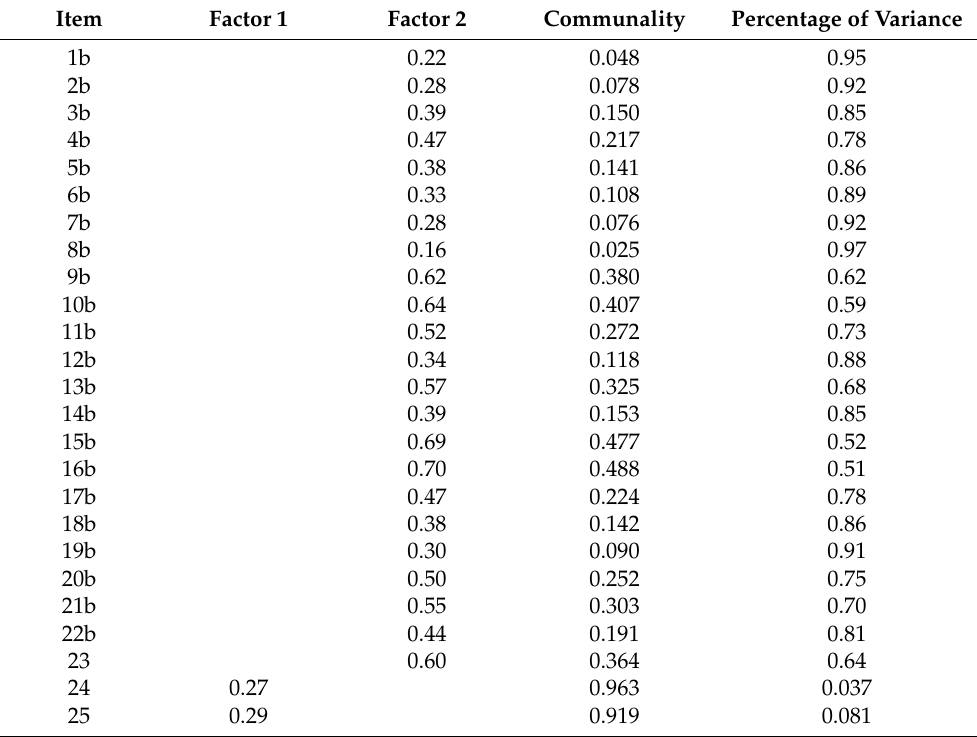
Table 3. Factor loadings, communality, and percentage of variance of items in relation to factors. Item Factor 1 Factor 2 Communality Percentage of